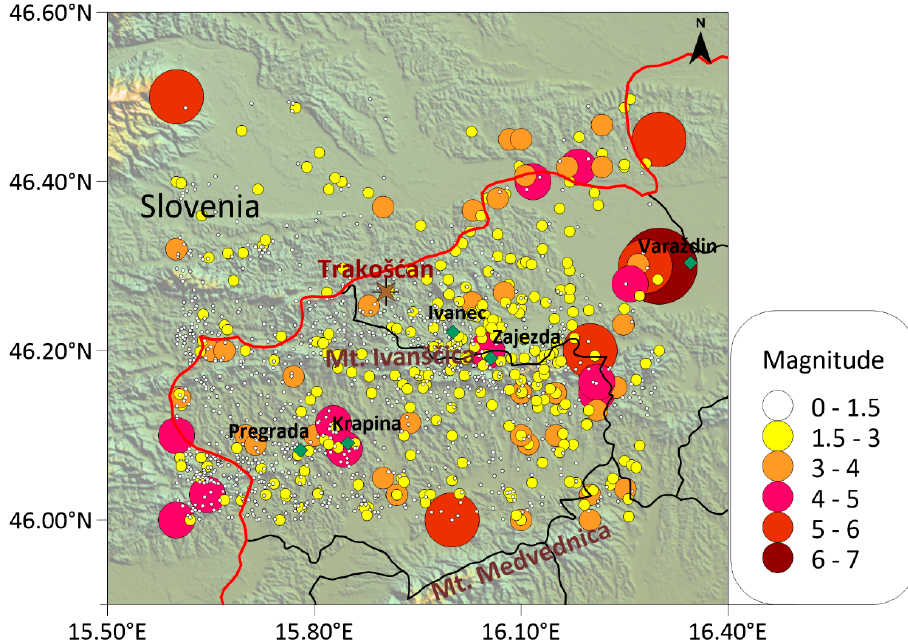
Figure 2. Spatial distribution of epicenters in the Trakoš´can area (BC–2019, according to the Croatian Earthquake Catalog (CEC), an updated version first described in [15]).